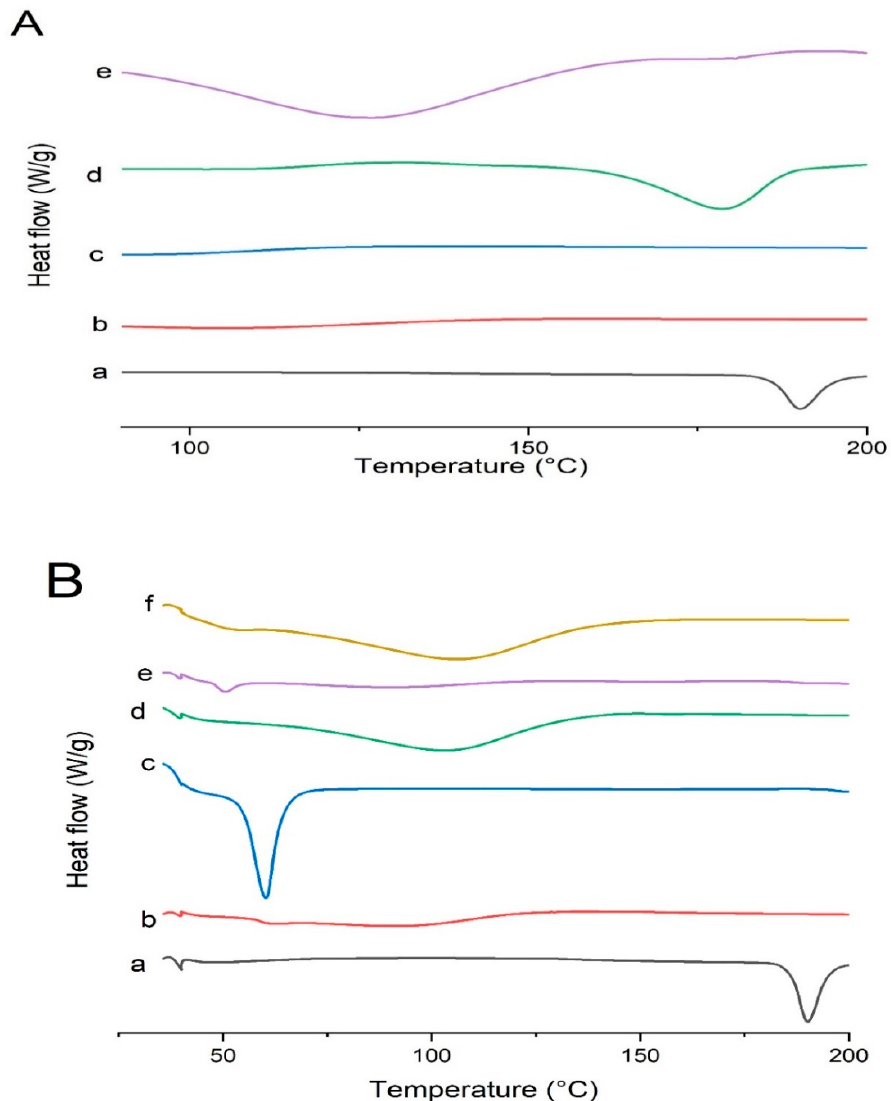
Figure 12. DSC curves of ( A ) Irbesartan and binary solid dispersions: (a) pure Irbesartan, (b) Soluplus ® , (c) Kollidon ® VA 64, (d) binary dispersion of drug and Soluplus ® at ratio 1:1 [S 1 ], (e) binary solid dispersion of drug and Kollidon ® VA 64 at ratio 1:4 [K 4 ]. ( B ) Irbesartan and ternary solid dispersions: (a) pure Irbesartan, (b) Kollidon ® VA 64, (c ) Kolliphor ® P 407, (d) Polyvinylpyrrolide-K30 (PVP-K30), (e) ternary solid dispersion KP407 (TD 3 ), (f) ternary solid dispersion KPVP (TD 3 ).